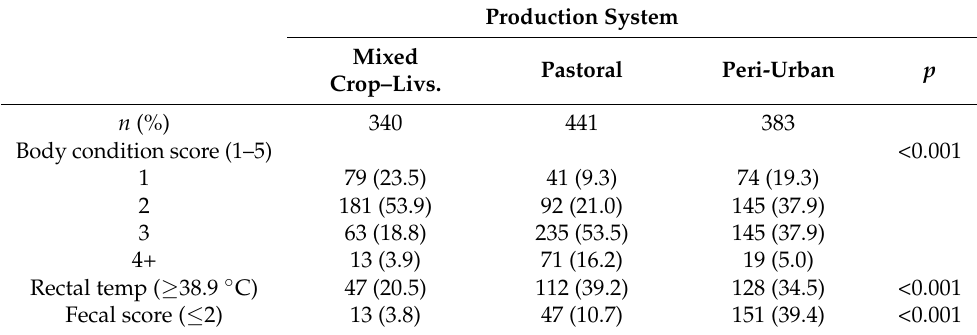
Table 4. Calf physical exam findings.